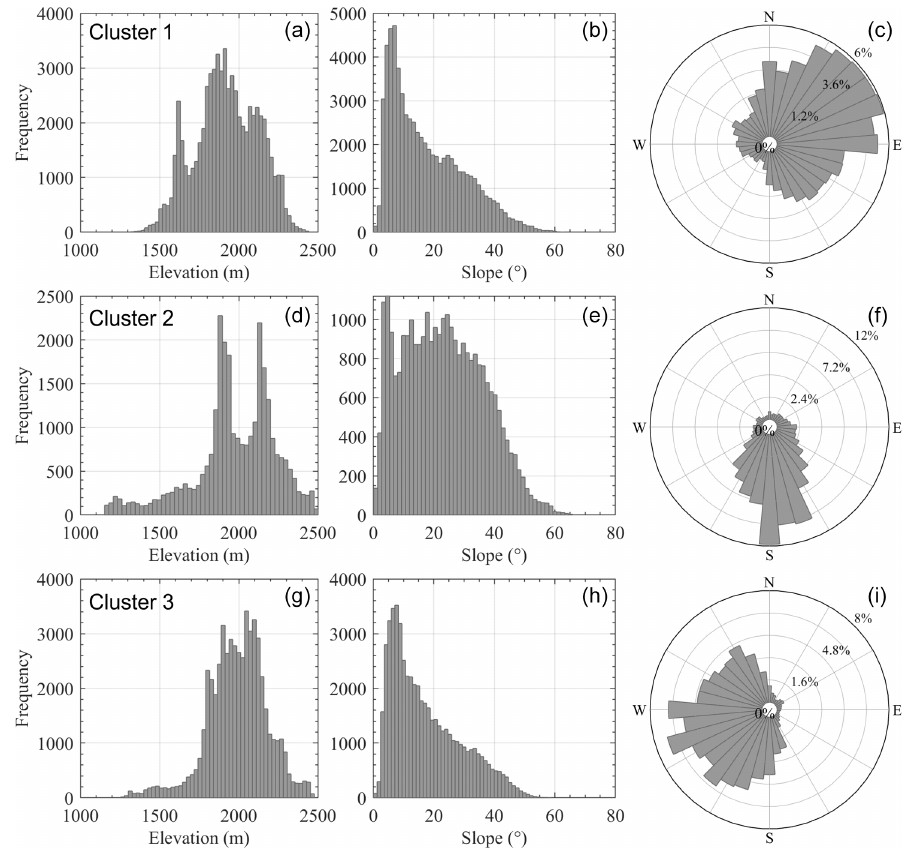
Figure 4. Topographic measures of (a, d, g) elevation, (b, e, h) slope and (c, f, i) aspect are calculated at 15m resolution from the NZSoSDEM for Cluster 1 (a–c) , Cluster 2 (d–f) and Cluster 3 (g–i) in the